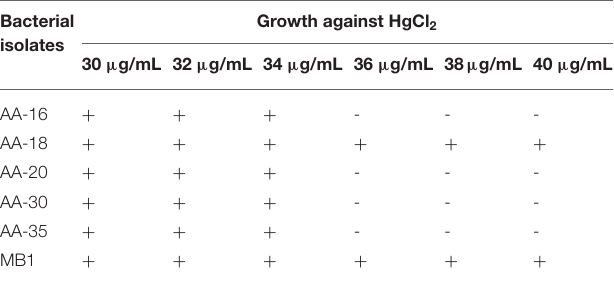
TABLE 1 | Bacterial isolates showing resistance at different concentrations of HgCl 2 .